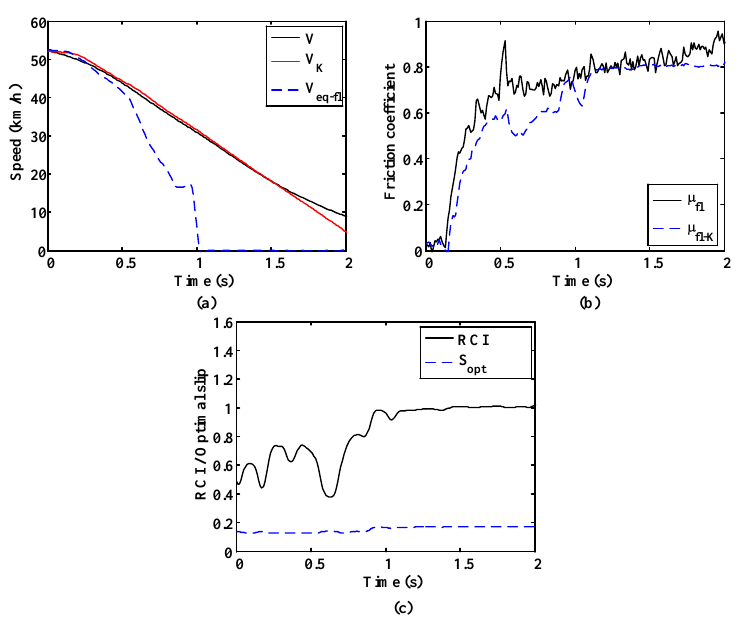
Figure 19. ( a ) Estimated and measured vehicle speed and wheel equivalent speed, ( b ) friction coefficient comparative, and ( c ) estimated road condition and optimal slip. Straight-line brake tests were carried out on dry asphalt and wet asphalt. The brake pedal was progressively pressed until maximum brake pedal travel was reached, remaining in that position until the complete stop of the vehicle.